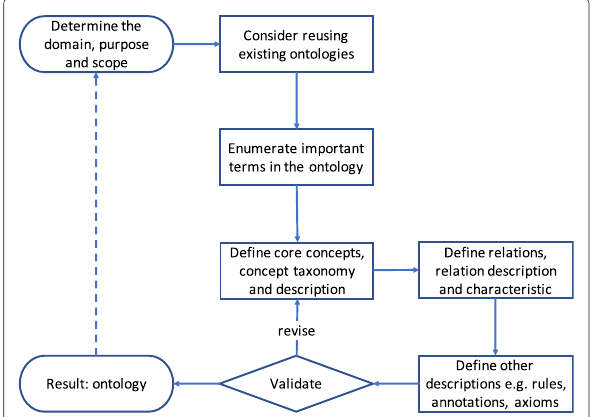
Fig. 1 Overview of methodology to develop domain ontology of social